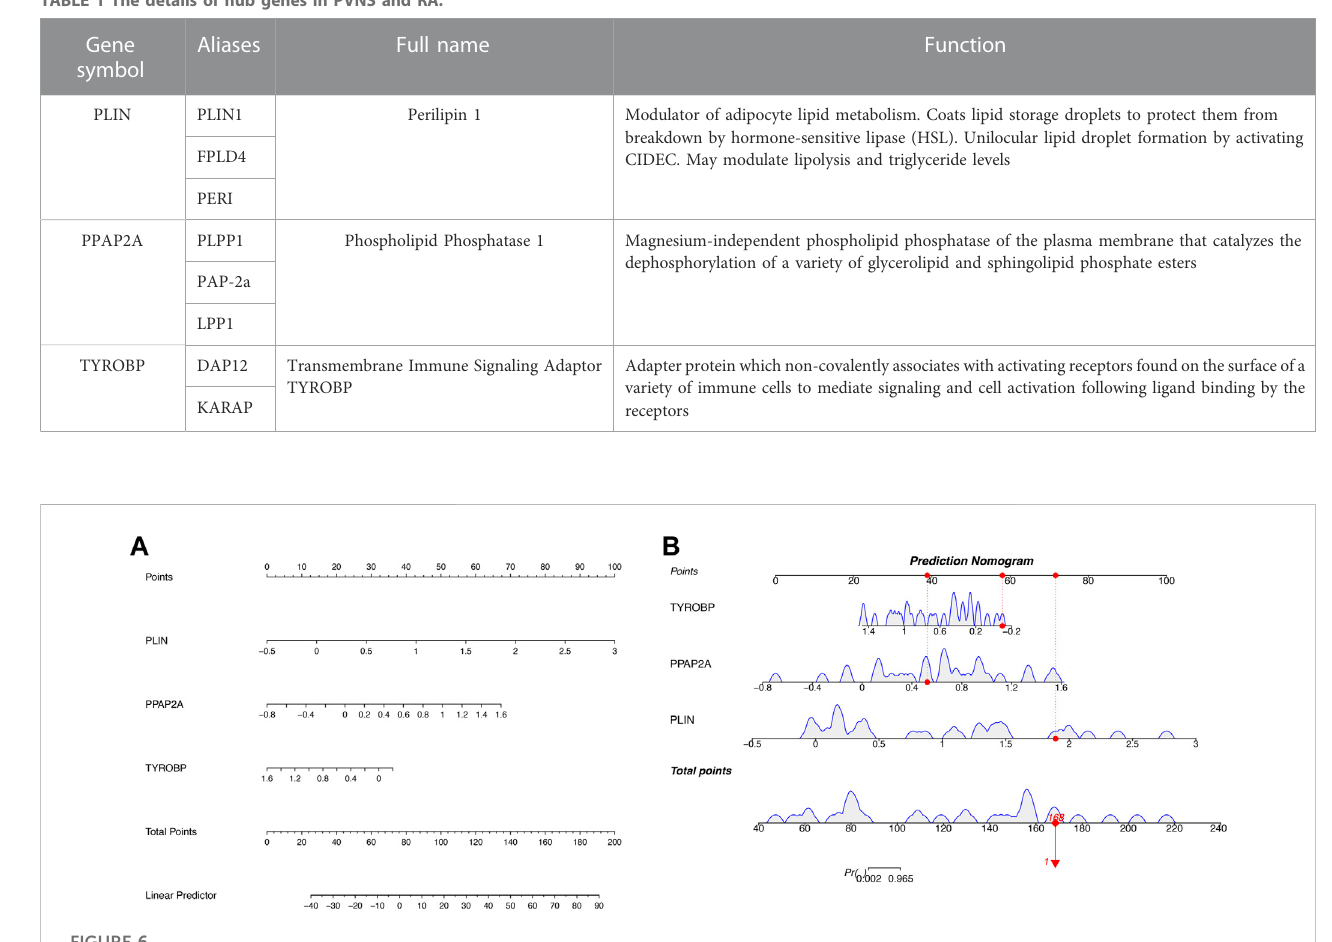
FIGURE 6 (A) AdevelopednomogramfortheprognosticpredictionofPVNSandRAhubgenes. (B) Thisgraphshowsthepredictedscoresafteraggregationofthree hub genes ’